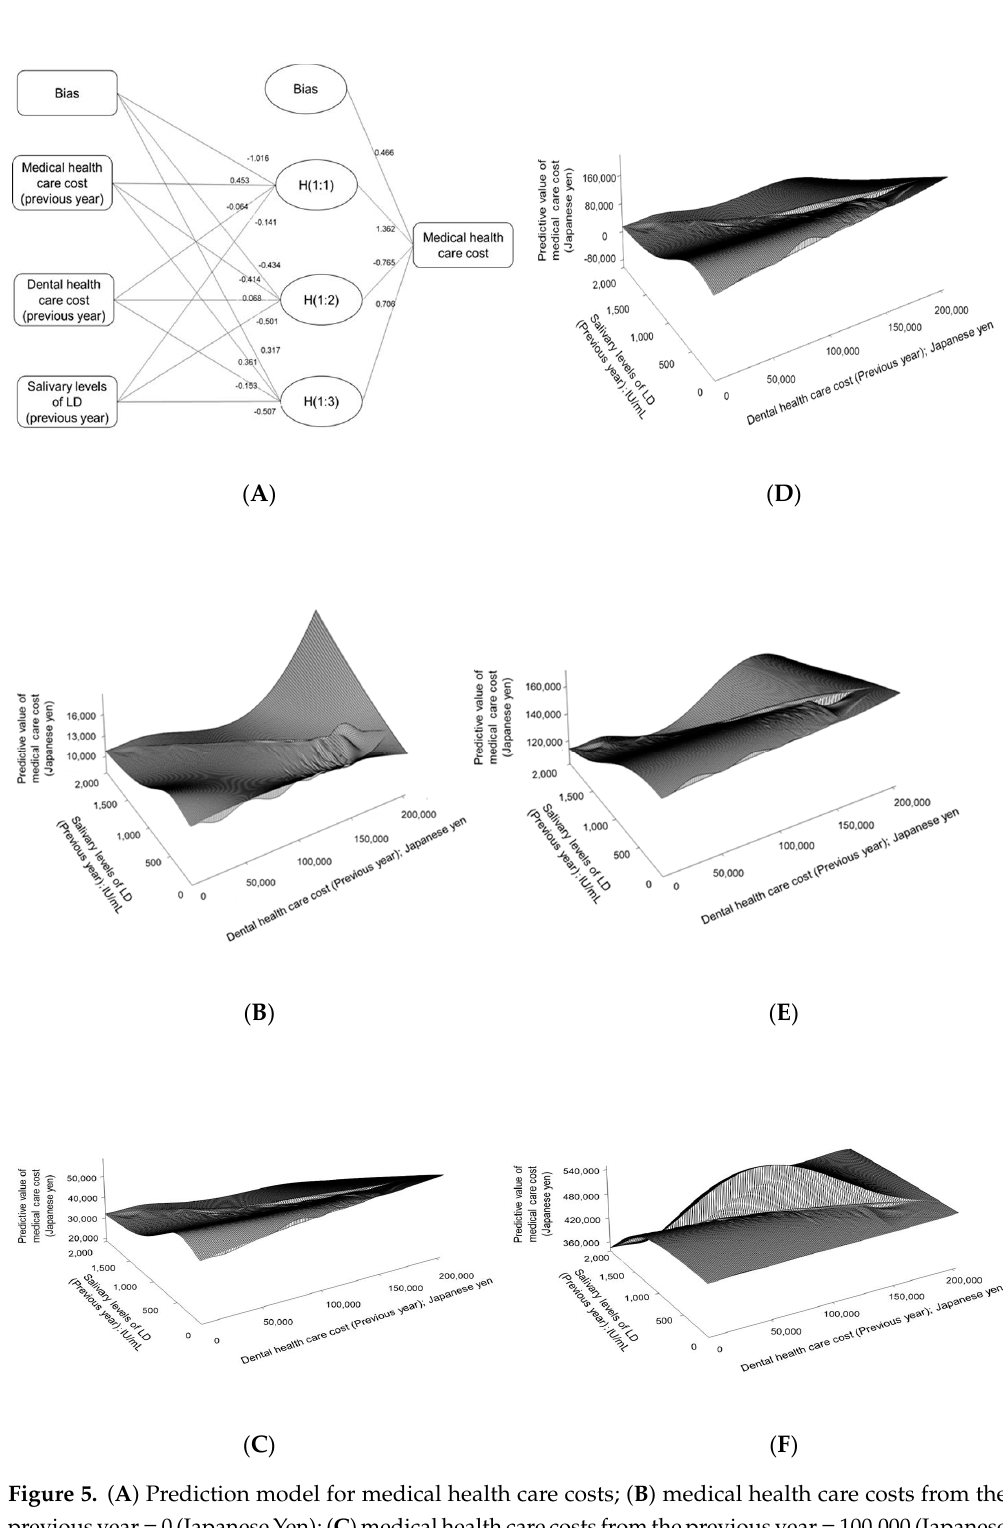
Figure 4. Results of the simulations of predictive values of health care costs by health care costs, dental health care costs, and salivary levels of LD.